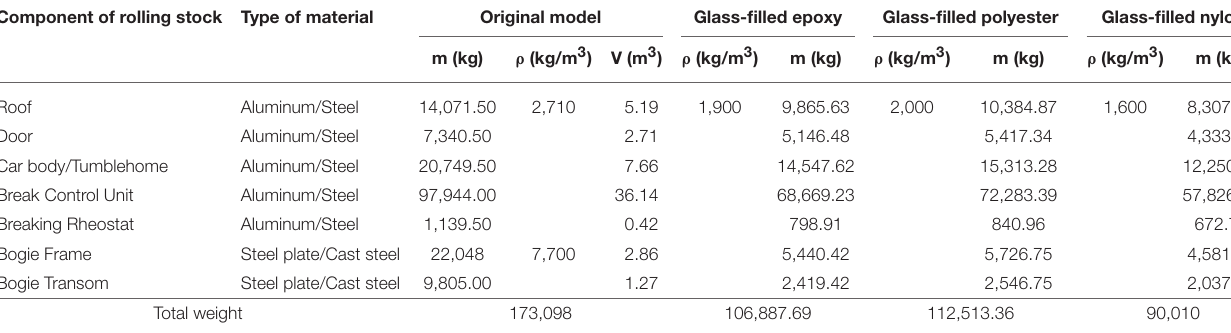
TABLE 1 | The calculation of the HSR weight in three case studies after composite material replacement. Component of rolling stock Type of